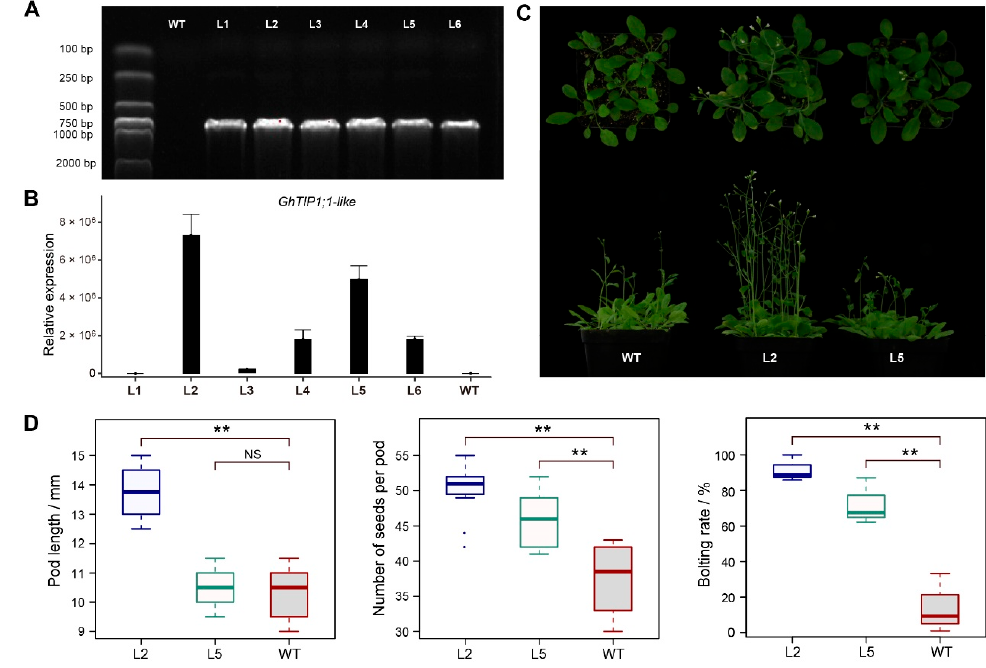
Figure 6. Overexpression of GhTIP1;1-like in Arabidopsis . ( A ) PCR analysis of transgenic plants. Lane M means DL2000 DNA marker; Lane WT means wild-type; Lanes L1-L6 means transgenic lines. ( B ) Expression levels of GhTIP1;1-like in Col-0 and transgenic lines determined by RT-qPCR. ( C ) Four-week-old WT and T2 transgenic plants. ( D ) Phenotypic characterization of WT and T2 transgenic plants. Three samples were measured in each experiment. Asterisks indicate a significant difference at p < 0.01 as determined by a Dunnett’s test, and NS indicate no significant difference at p < 0.05.